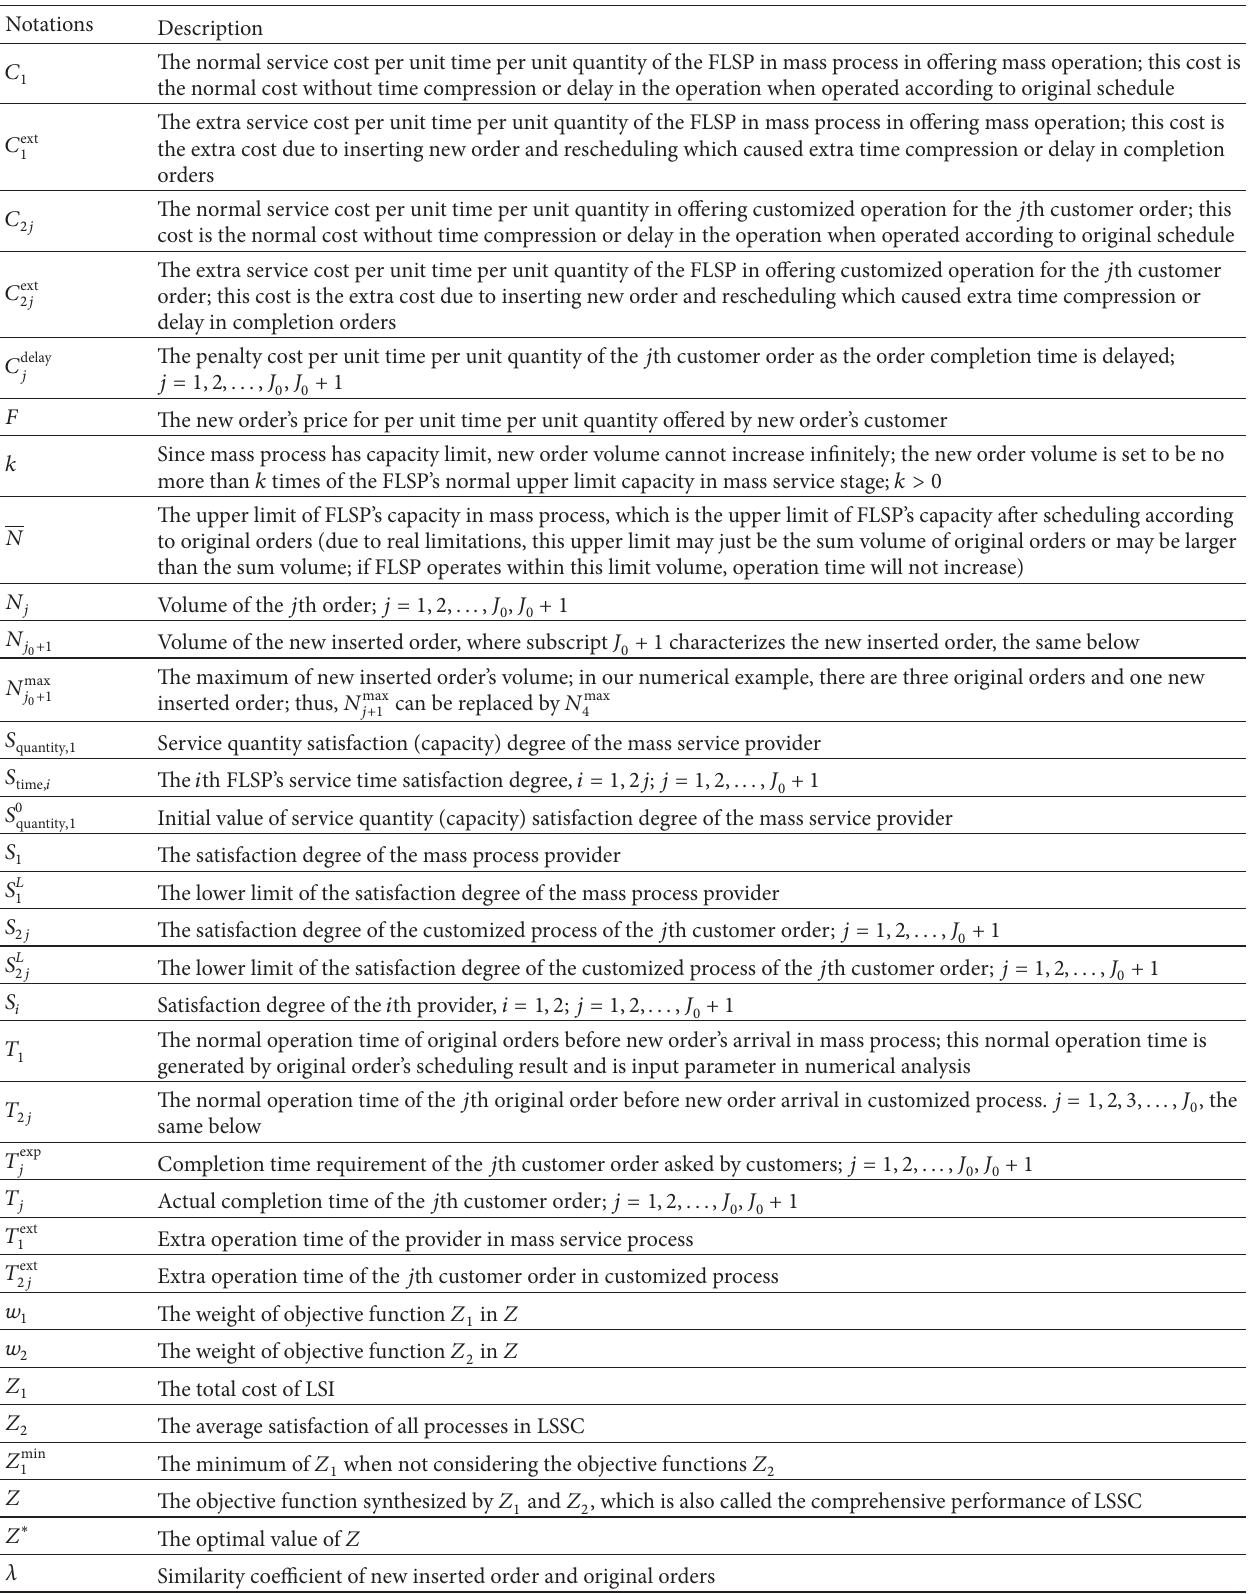
Table 1: Notations for the